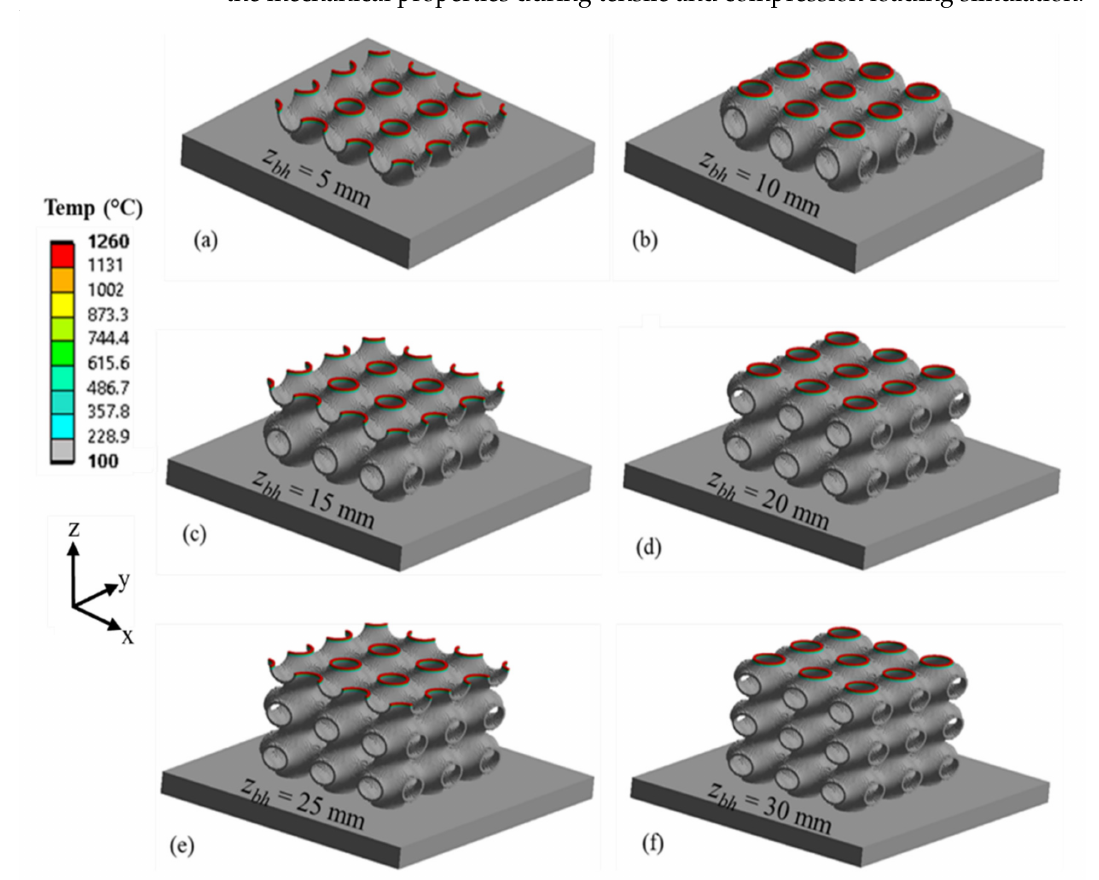
Figure 7. Various stages of 3 × 3 × 3 AM buildup simulation for P-S ( ρ =10%) for build height: ( a ) z bh = 5 mm, ( b ) z bh = 10 mm, ( c ) z bh = 15 mm, ( d ) z bh = 20 mm, ( e ) z bh = 25 mm, and ( f ) z bh = 30 mm at completion of